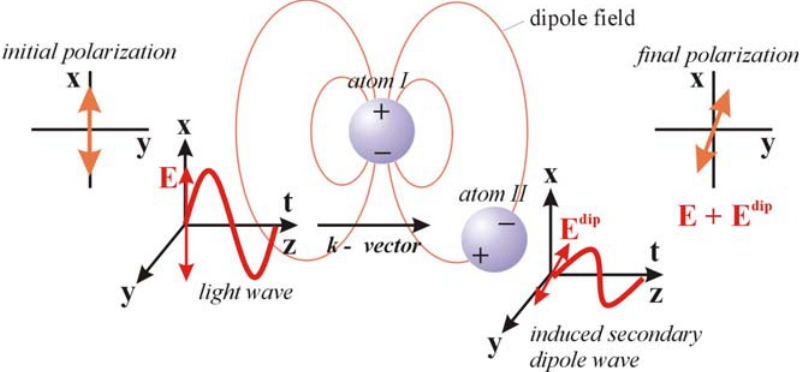
Figure 3. Illustration of the dipole-dipole interaction theory (image from [38], reproduced by permission of The Royal Society of Chemistry). When an initial wave with polarization E passes the first atom positioned at (x,0,0) in a Cartesian reference system ( z // k , k is the wave vector), a dipole field is created which induces in a second atom at (0,y,z) a secondary dipole field. This field oscillates in a direction different to E for y, z ≠ 0. The interference of all induced waves with the initial wave (calculated via an Ewald sum) on passing through the crystal leads to a rotation of E when the atoms adopt a chiral arrangement.